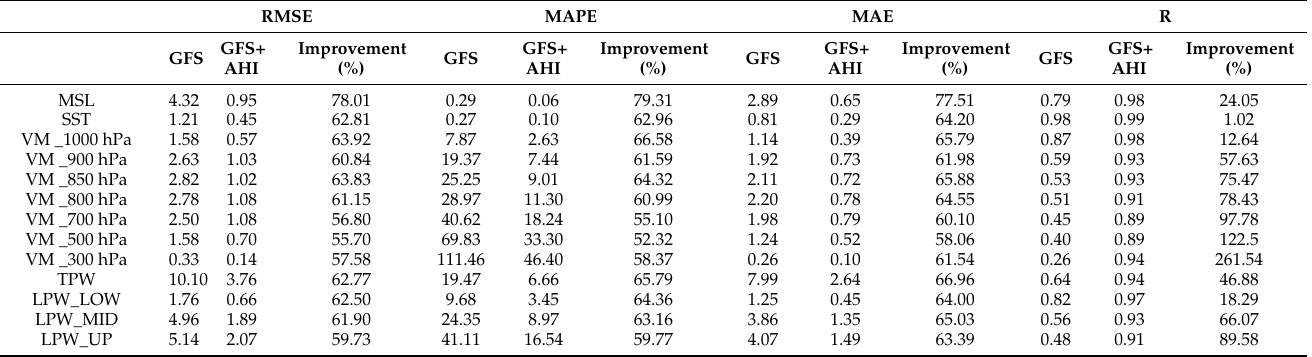
Table 5. Accuracy improvements of the retrievals from RF-based algorithm using AHI+GFS as inputs over the GFS